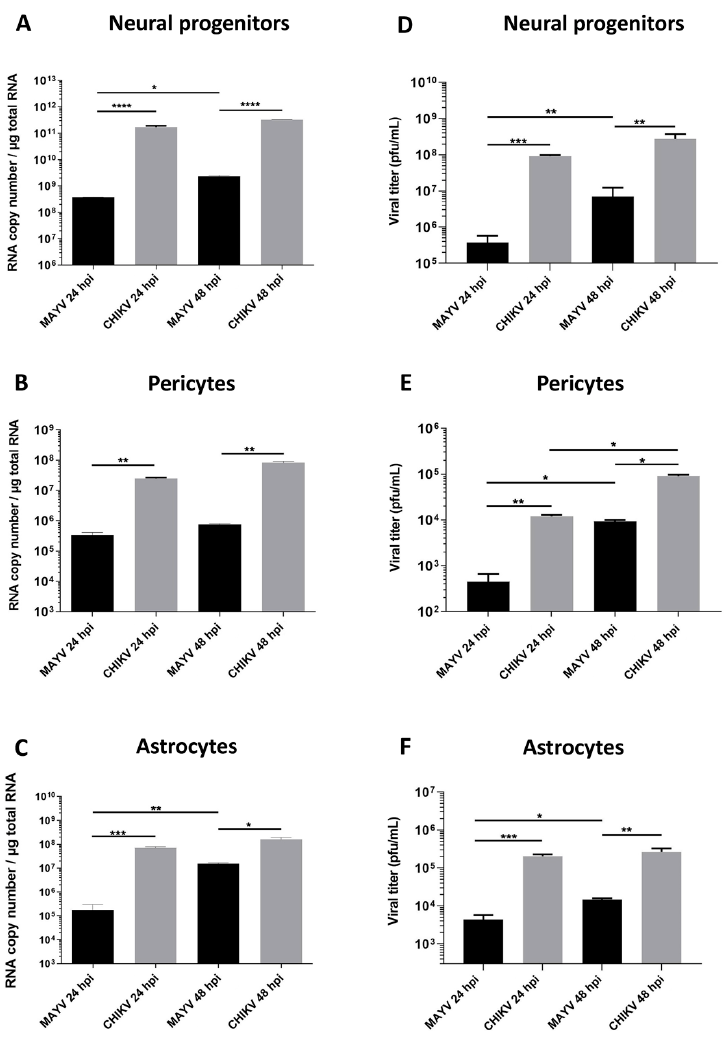
Figure 1. Human neural progenitors, pericytes and astrocytes are permissive to Mayaro virus (MAYV) and chikungunya virus (CHIKV) infection. Cells were infected with either MAYV or CHIKV at multiplicity of infection (MOI) 5 at 24 and 48 hpi. RT-qPCR was performed to measure viral RNA level ( A – C ). Infected cell supernatants were analyzed by plaque assay to quantify infectious viral particles ( D – F ). Statistical analyses were done from three independent experiments each performed in triplicate. Comparisons between the data at the indicated time points using a one-way ANOVA test. p -value; * p < 0.05, ** p < 0.01, *** p < 0.001, **** p < 0.0001.